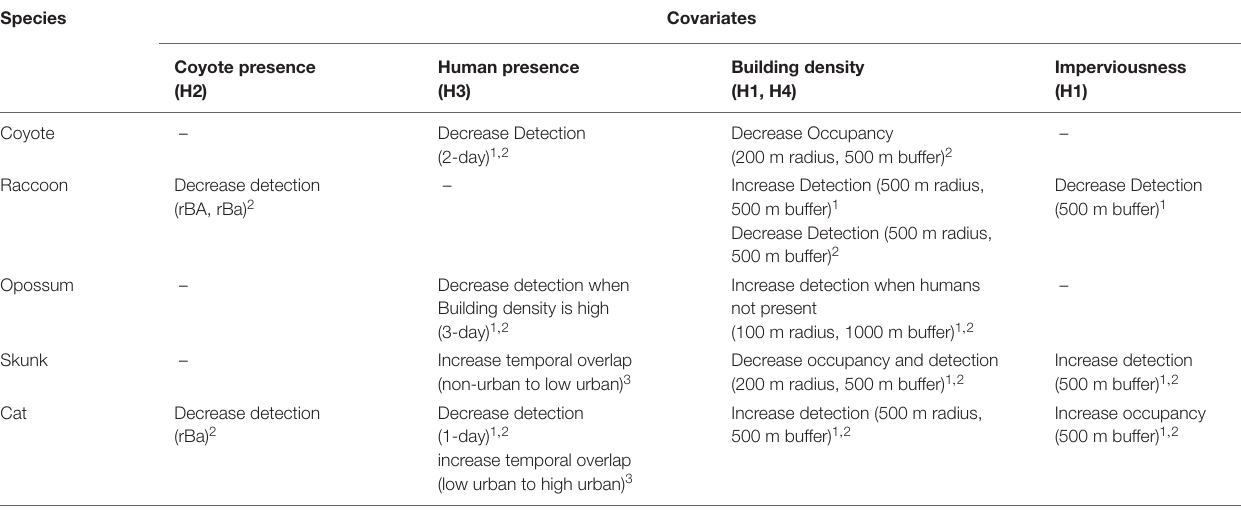
TABLE 1 | Summary of important covariates effects and associated hypothesizes on mesopredator species. Species